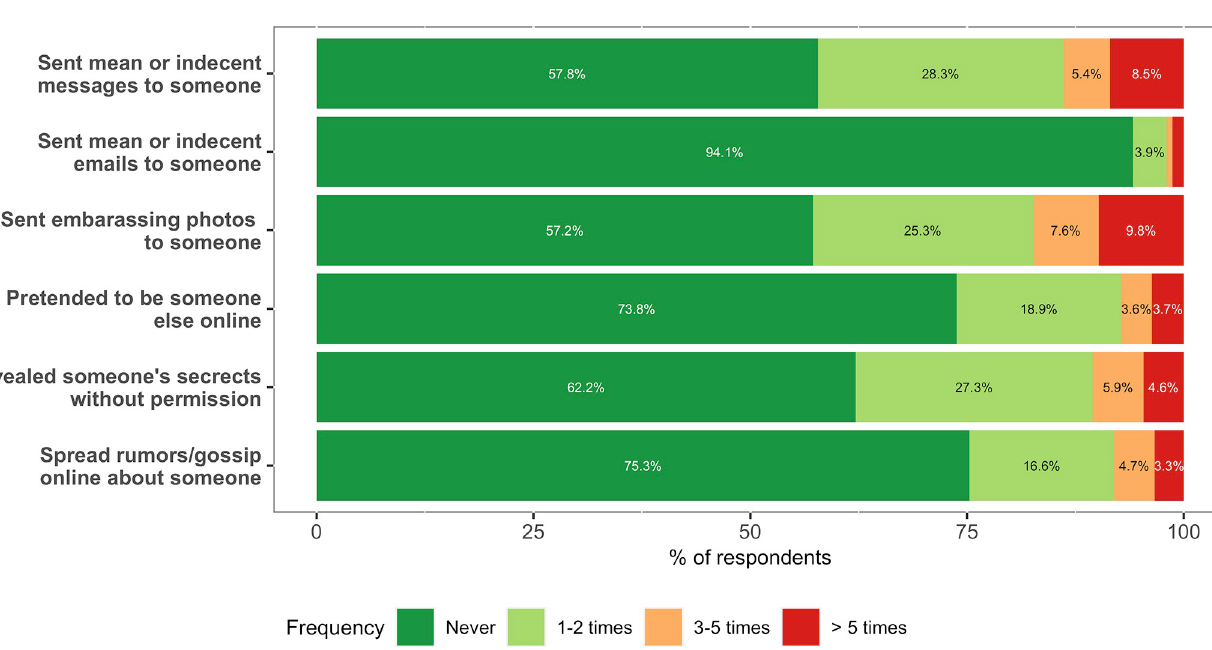
Fig 2. Self-reported frequency of cyberbullying. Stacked frequencies bar charts showing the distribution of responses about the self-reported frequency of different types of cyberbullying behaviours.